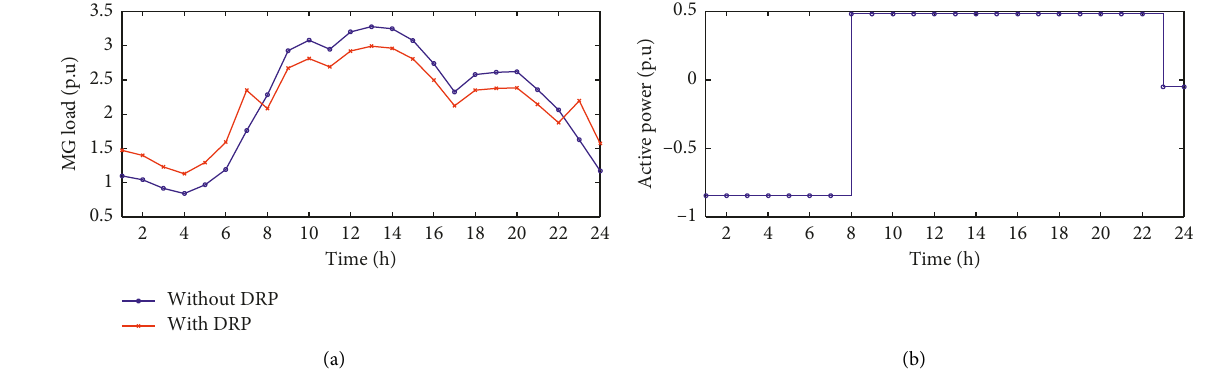
Figure 7: Expected daily curve of (a) MG load and (b) battery active power.